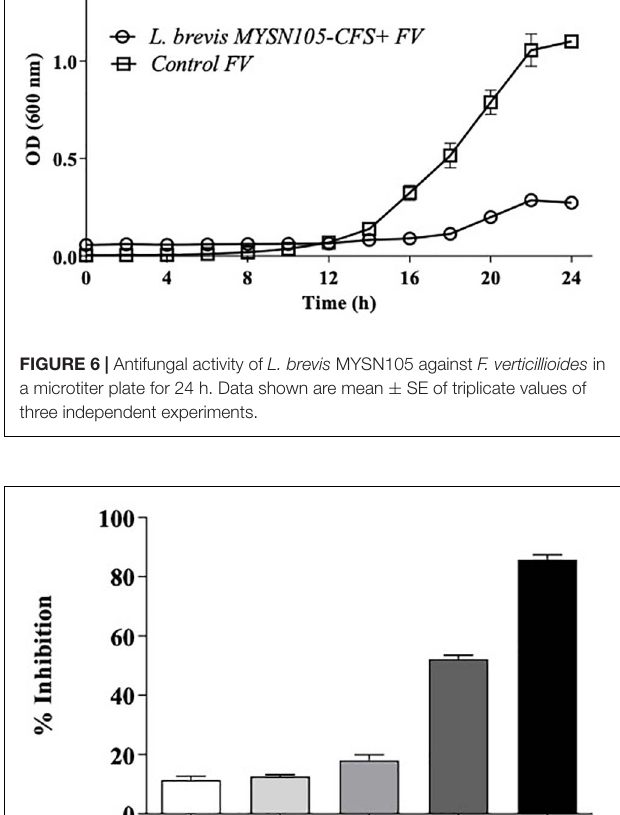
showed deformation and were reduced to 23.41% ± 1.12 CFS, respectively.